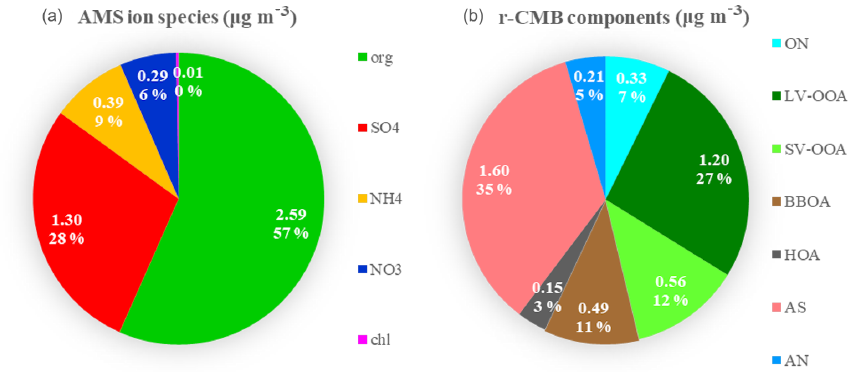
Figure 6. Mass attribution in the default AMS speciation scheme (a) and by r-CMB components (b) for all eight data sets combined. Values are (data set length-weighted) averages for all data combined. Absolute mass concentrations are in units (µgm − 3